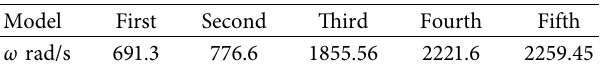
Figure 6: Critical rotor speed. Table 1: Natural